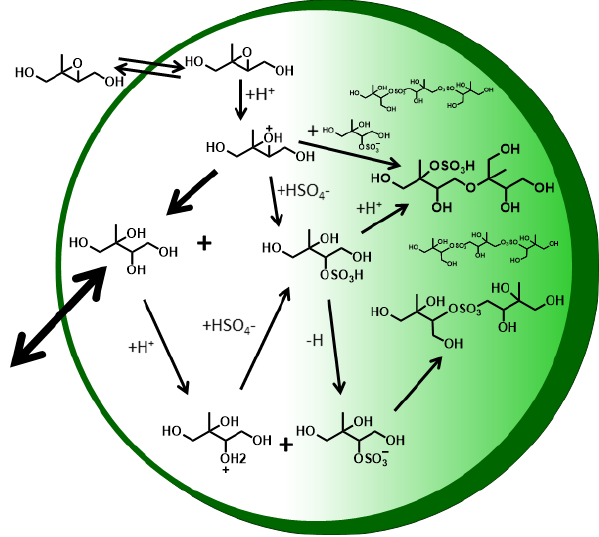
Figure 7. Hypothetical schematic of IEPOX reactive uptake and particle-phase processes. White region denotes semi-volatile species that actively partition between the gas and particle phases, light green denotes species that are of lower volatility, and dark green outline denotes a